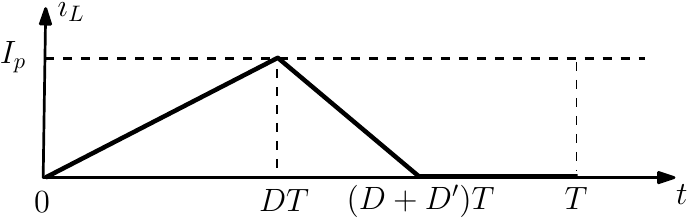
Figure 8. Sketch of the inductor current i L waveform for any DCM-operated elementary